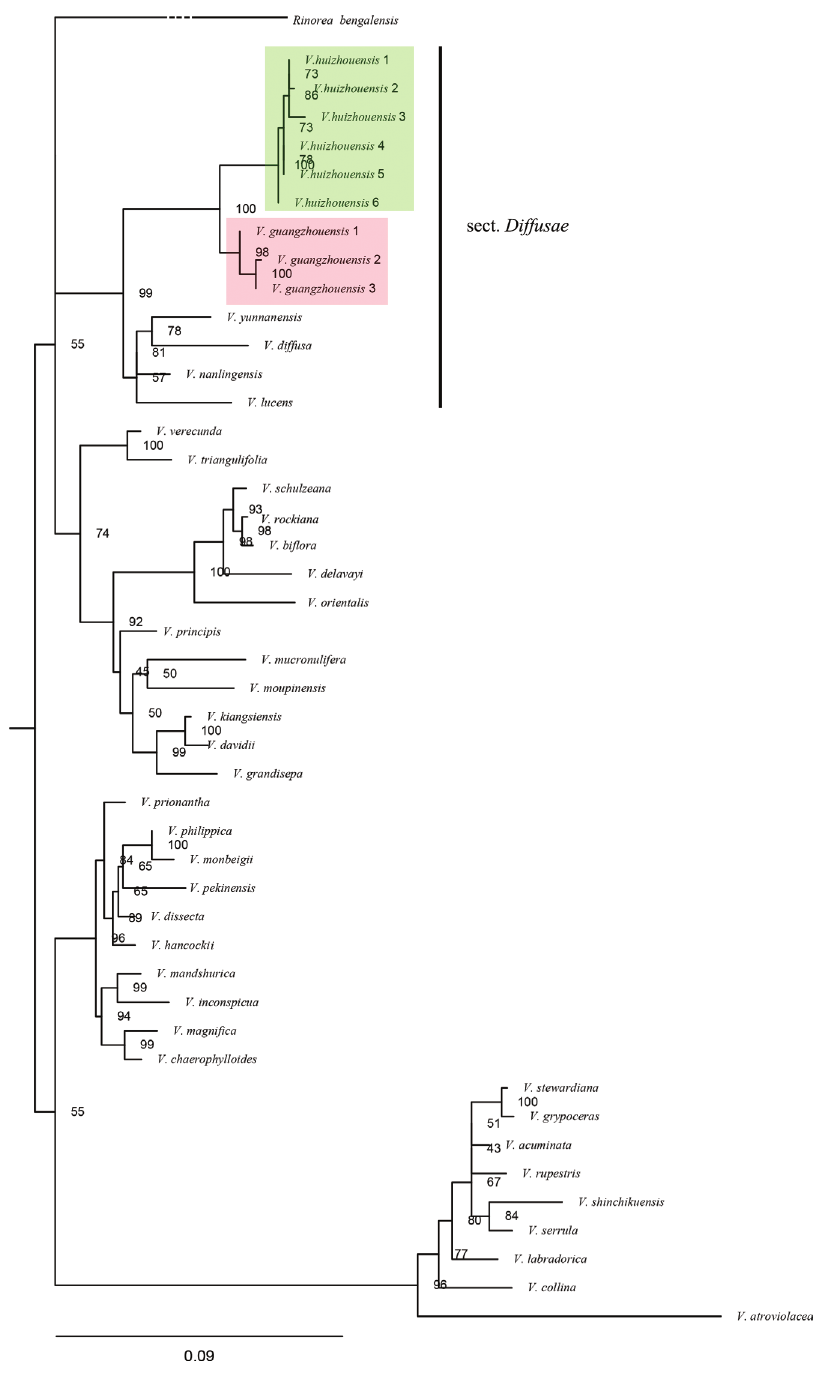
Figure 1. Maximum Likelihood tree of the new species and related species, Numbers beside branch nodes are bootstraps. Outgroups: Rinorea bengalensis . Viola huizhouensis clade is marked in green and V. guangzhouensis clade is marked in